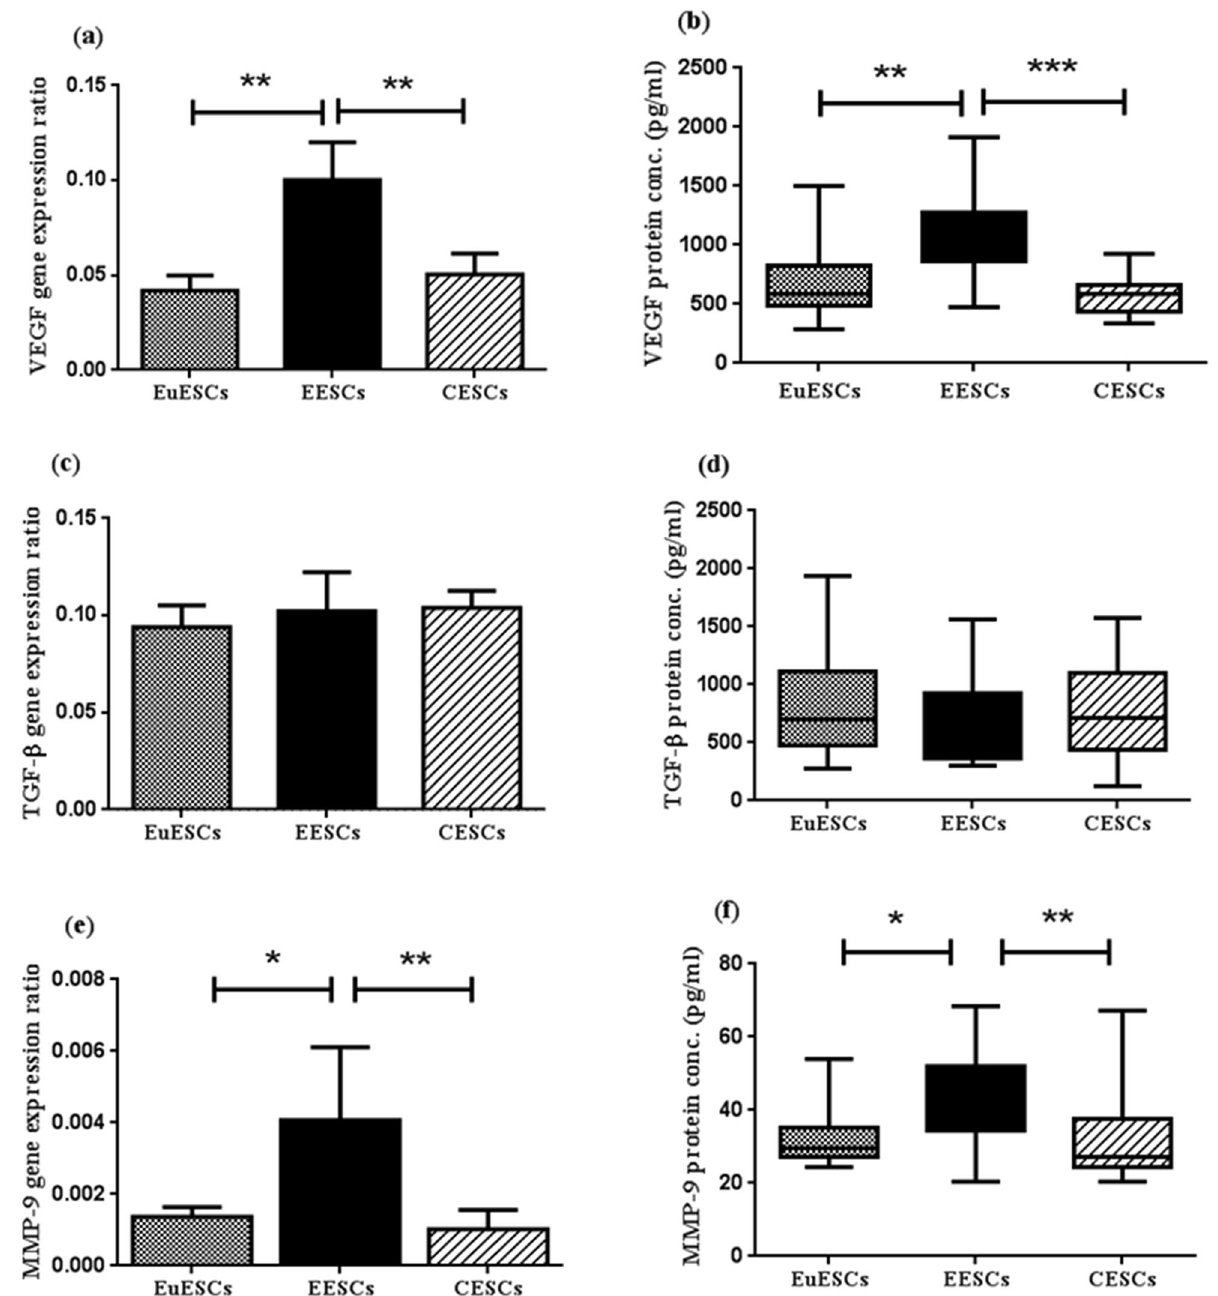
Figure 1. The basal expression levels of VEGF, TGF-β and MMP-9 genes and proteins in ESCs. The basal expression of VEGF, TGF-β and MMP-9 genes and proteins were measured in EESCs (n = 8) and EuESCs (n = 13) from endometriotic women and CESCs from non-endometriotic controls (n = 11) by real-time PCR and ELISA. ( a ) The basal expression of VEGF gene, ( b ) The basal expression of VEGF protein, ( c ) The basal expression of TGF-β gene, ( d ) The basal expression of TGF-β protein, ( e ) The basal expression of MMP-9 gene, ( f ) The basal expression of MMP-9 protein. *P-value < 0.05, ** P-value < 0.01 and *** P-value < 0.001 by non- parametric tests. VEGF: Vascular endothelial growth factor, TGF-β: Transforming growth factor-β, MMP-9: Matrix metalloproteinase-9, ESCs: Endometrial stromal cells, EuESCs: Eutopic endometrial stromal cells, EESCs: Ectopic endometrial stromal cells, CESCs: Control endometrial stromal